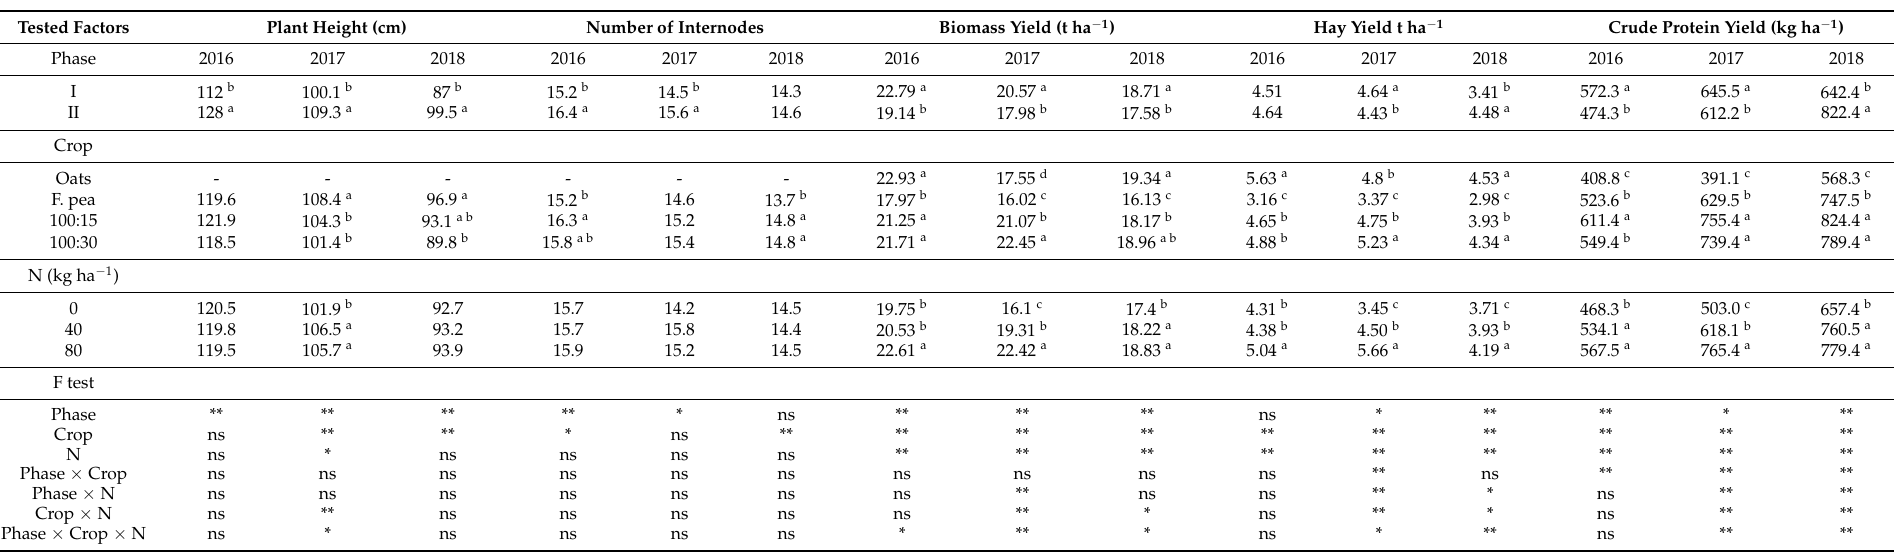
Table 4. Different yield components of field pea and oat sole crops, and their mixtures under three fertilizer levels and two mowing